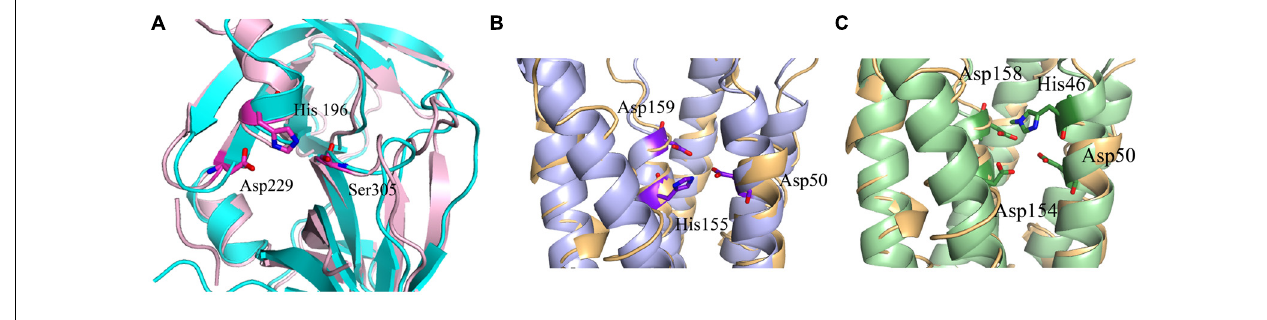
FIGURE 4 | Predicted catalytic/ binding sites of MamE, MamM, and MamB. (A) MamE predicted structure (light pink) overlapping with serine protease structure (cyan); the catalytic triad is shown as sticks. (B) Overlap of the MamM predicted structure (light blue) with zinc transporter FieF (light